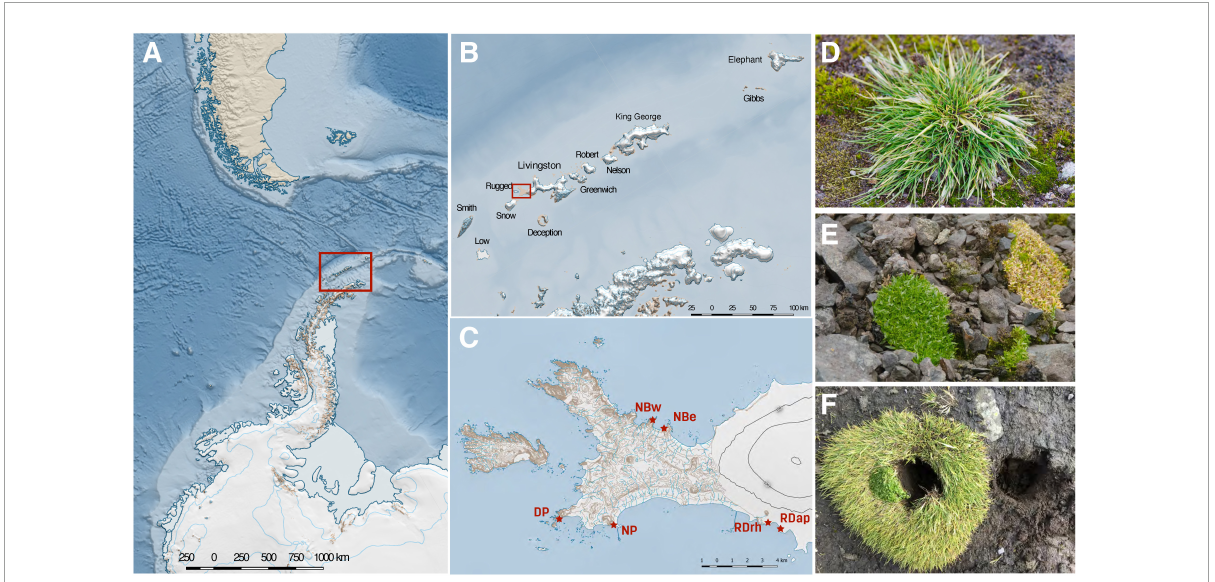
FIGURE1 Map and description of the study sites. The six sampling sites are located in the Byers Peninsula, Livingston Island, Antarctica. The study site (A) is located in the maritime Antarctica, specifically in Livingston Island (B) . The Byers Peninsula is devoid of ice during the Austral Summer (C) , which favors the growth of both Deschampsia antarctica [Da] (D) and Colobanthus quitensis [Cq] (E) . In some instances, C. quitensis grows in association with D. antarctica [Da.Cq] (F) . NBw and NBe = North Beach West and East, respectively; DP and NP = Devils Point and Nikopol Point, respectively; and RDrh and RDap = Rotch Dome Ritli Hill and Rotch Dome Amadok Point,